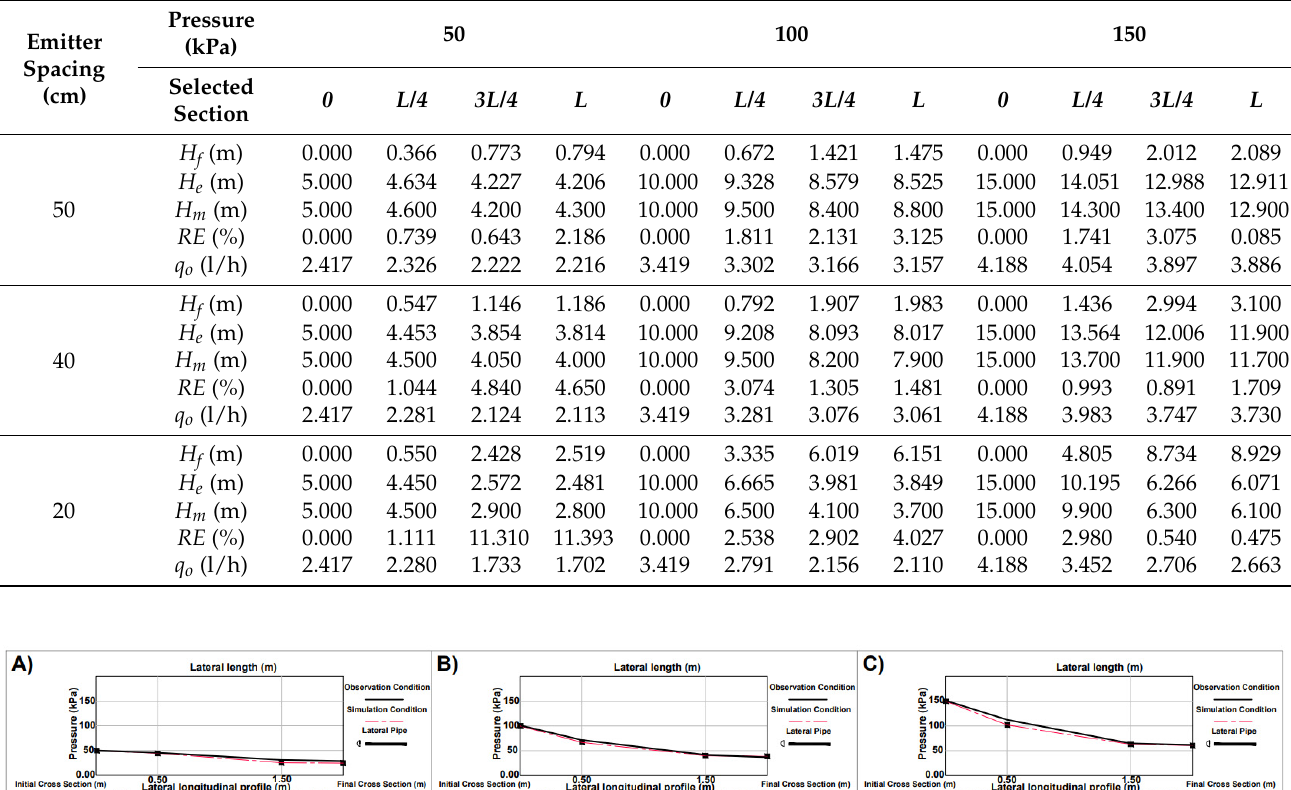
Table 2. Summary of the hydraulic analysis results including the head losses, the measured ( Hm ) and estimated ( He ) pressure heads, their relative difference ( RE ), and the mean discharge of the buried emitters ( q o ).